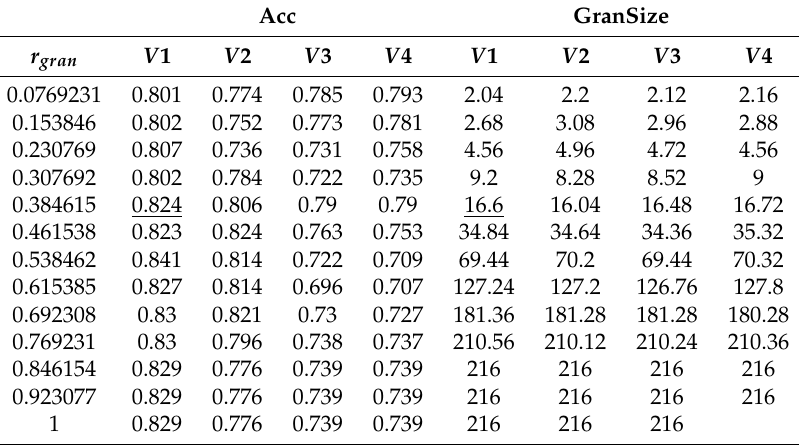
Table 23. 5 × CV-5; The result of experiments for four variants of the Naive Bayes classifier; data set Heart disease; Concept dependent granulation; r gran = Granulation radius; nil = result for data without missing values; Acc = Accuracy of classification; GranSize = The size of data set after granulation in the fixed r